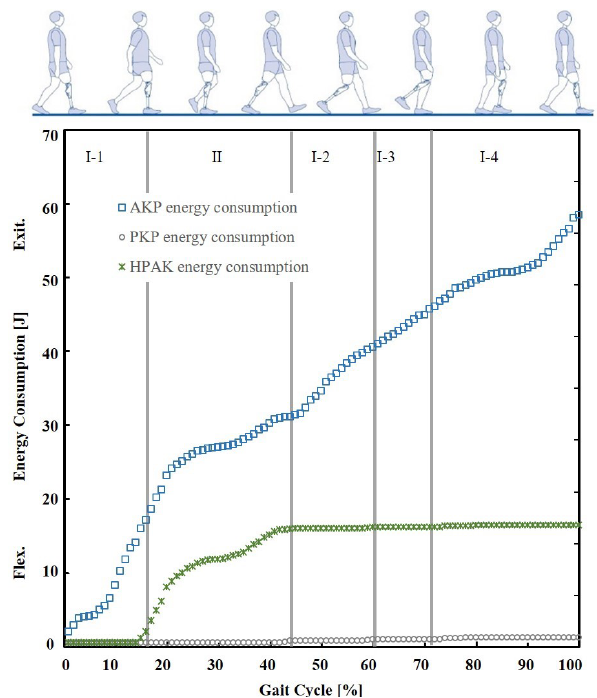
Figure 15. Energy consumption under the three simulation condi- tions when walking on level